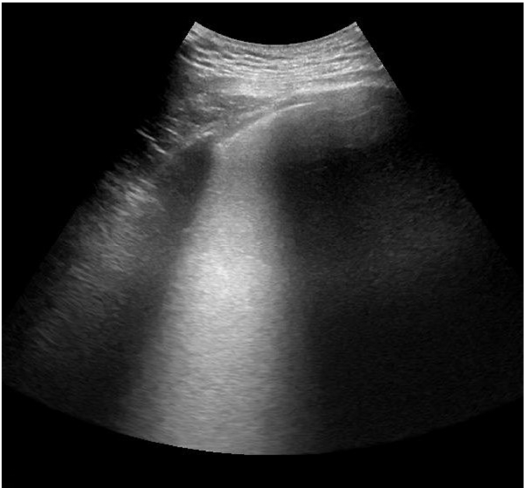
Figure A3. Coalescent B-lines (B2)—score 2. J. Clin. Med. 2022 , 11 , x FOR PEER REVIEW